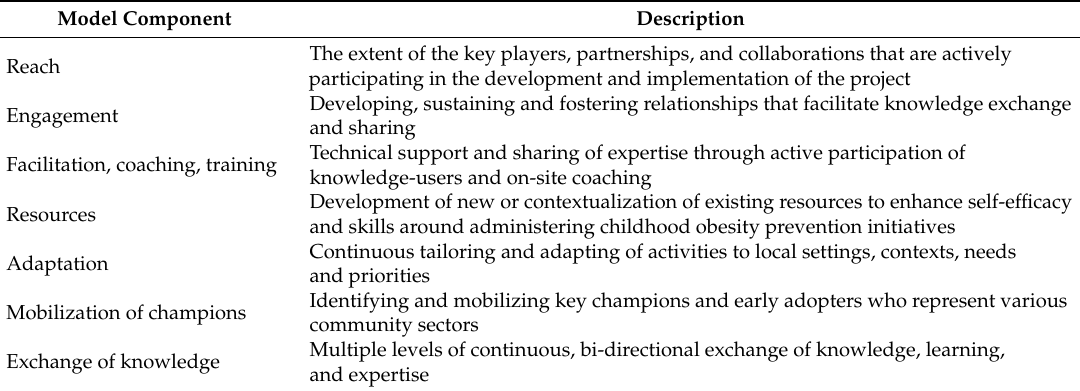
Table 1. The RE-FRAME knowledge exchange